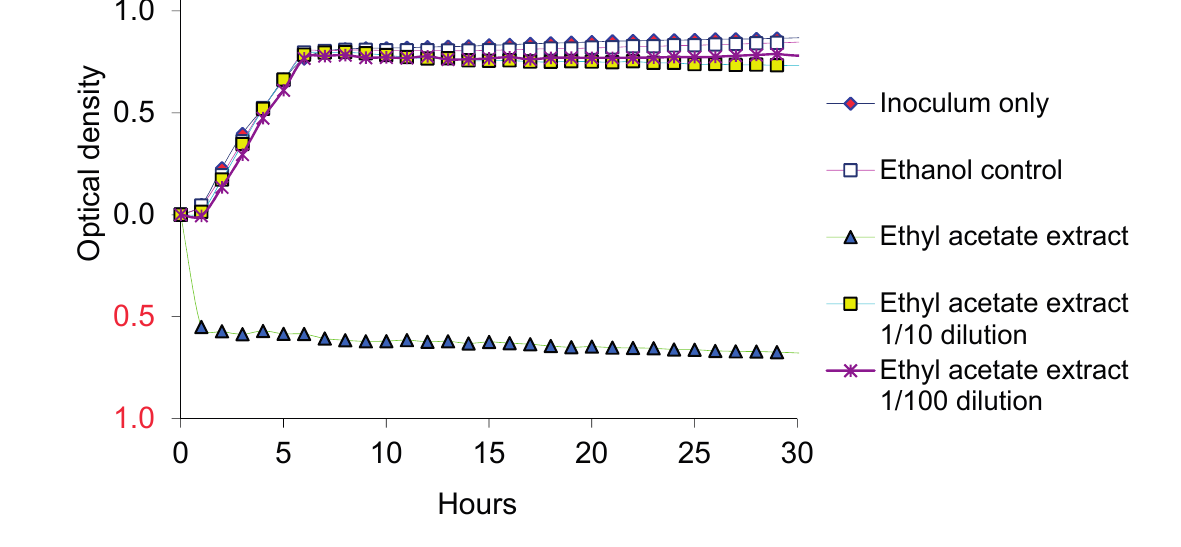
Figure 3. Growth of EcO157 in LB broth supplemented with ethyl acetate extracts of neem leaf. Optical densities at all sampling intervals were corrected for zero-time